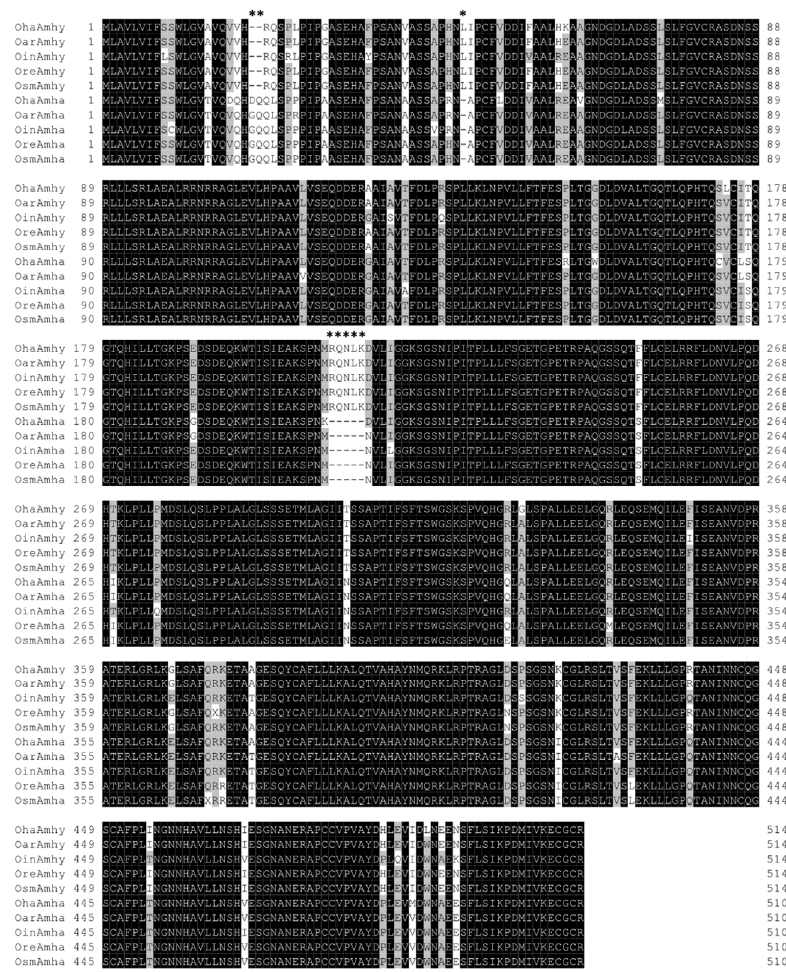
Figure 3. Alignment of the predicted amino acid sequences of amha and amhy genes in four Odontesthes species. Oha: Odontesthes hatcheri ; Oar: O. argentinensis; Oin: O. incisa; Ore: O. regia; Osm: O. smitti . Identical residues and conserved substitutions are highlighted by black and gray background, respectively. Asterisks represent conserved insertions and deletion. The boxed region represents the TGF-beta domain with conserved seven canonical cystein residues (S).